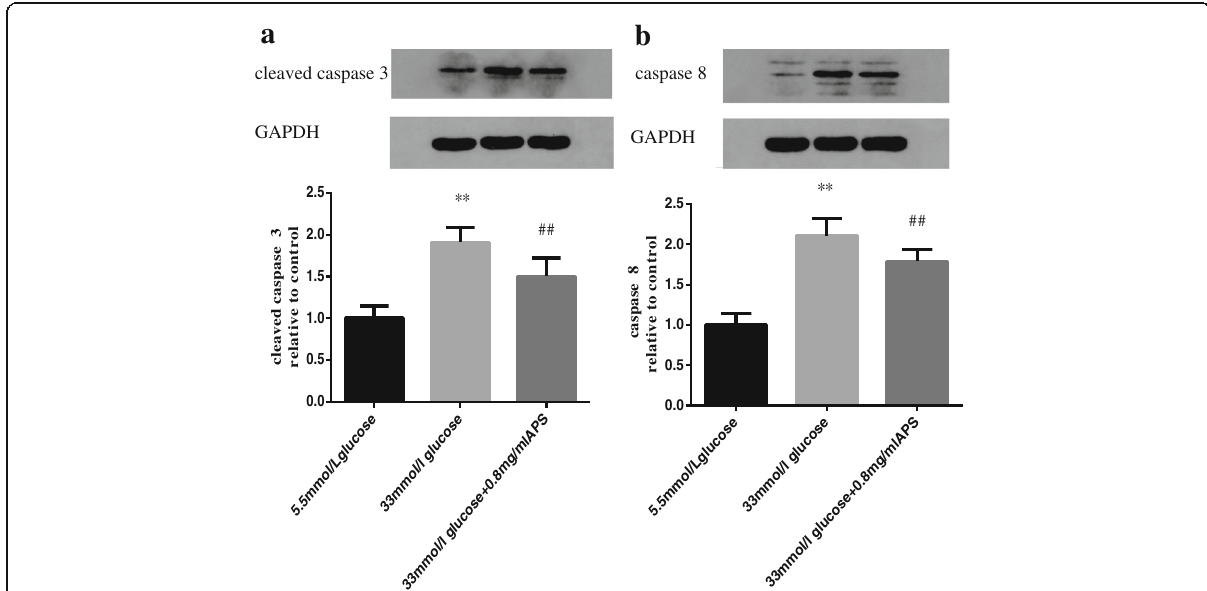
Fig. 7 APS modulated apoptosis-related proteins in the extrinsic pathways. H9C2 cells were pre-incubated with/without APS for 24 h and then treated with 33 mmol/L glucose for 24 h. The expression of GAPDH was measured as an internal control for the cytoplasmic fraction. a . Semi-quantitative expressions of cleaved caspase 3 in different groups. b . Semi-quantitative expressions of caspase 8 in different groups. Data were expressed as Mean ± SD. ** P < 0.01 versus 5.5 mmol/L glucose group; ## P < 0.01 versus 33 mmol/L glucose